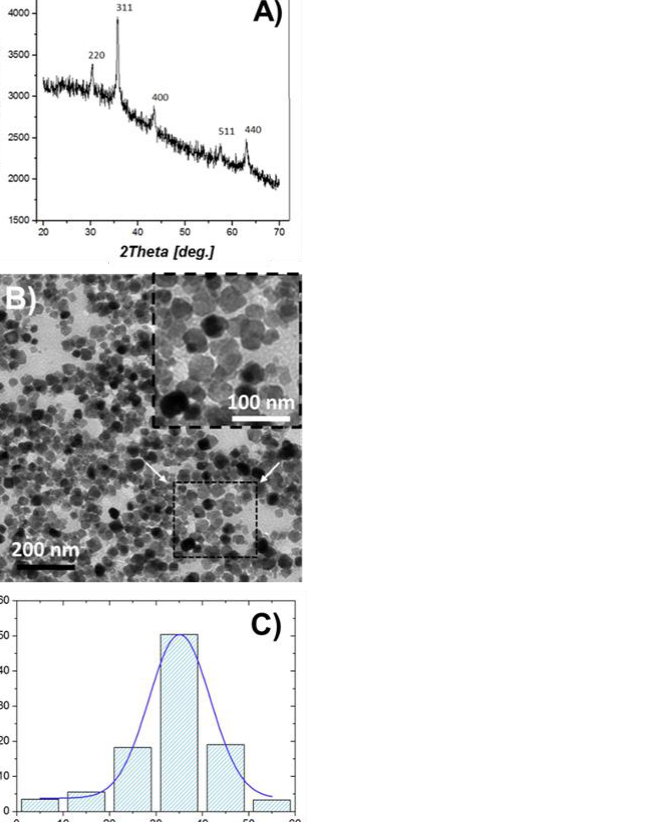
Figure 1. Magnetite crystals synthesized in the presence of MamC (10 μg/mL) ( biomimetic magnetic nanoparticles, BMNPs): ( A ) X-ray diffraction (XRD); ( B ) transmission electron microscopy (TEM) image and magnification of a selected area; ( C ) crystal size distribution.